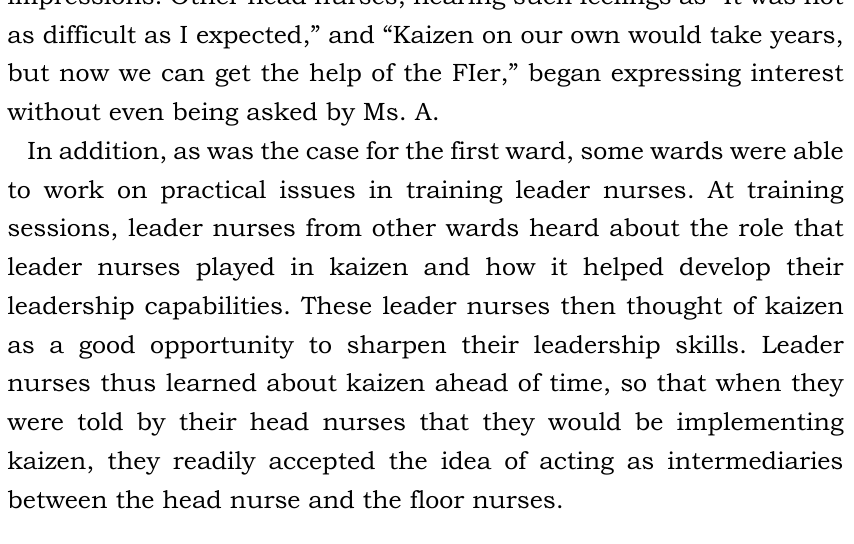
Table 1. Summary of kaizen in each ward Disease region